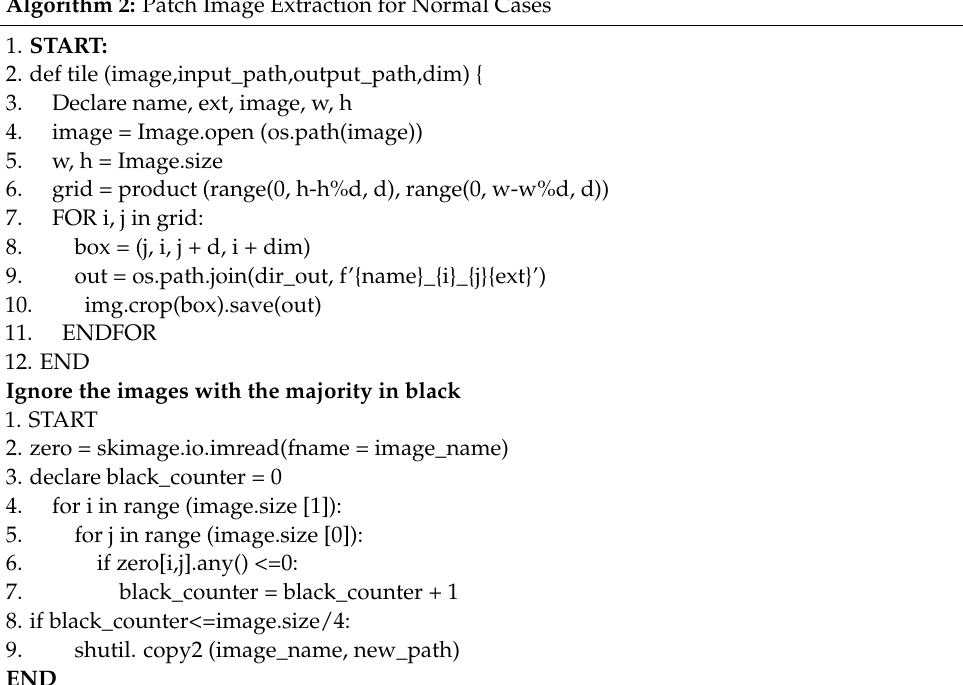
Algorithm 2: Patch Image Extraction for Normal